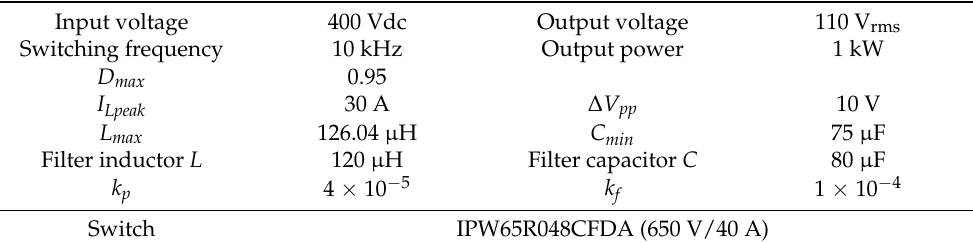
Table 1. Simulation and experimental parameters.